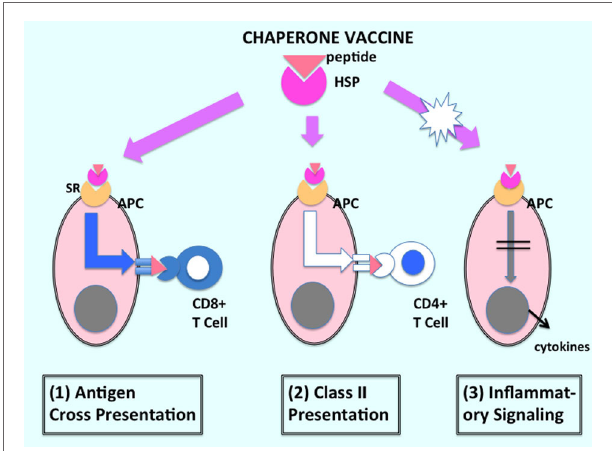
FiGURe 1 | immune activation by HSP-based anticancer vaccines . The HSP–peptide complexes that comprise the anticancer vaccine are shown to interact with APC after vaccination of host. The vaccines can efficiently (1) cause cross-presentation of tumor antigen and, thus, prime CD8 + T lymphocytes as well as activating CD4 + T cells through the (2) class II pathway. However, many investigations suggest that HSPs may not have major effects on (3) inflammatory signaling and may require combination with agents with adjuvant activity or inflammatory cell killing. Gray spheres indicate